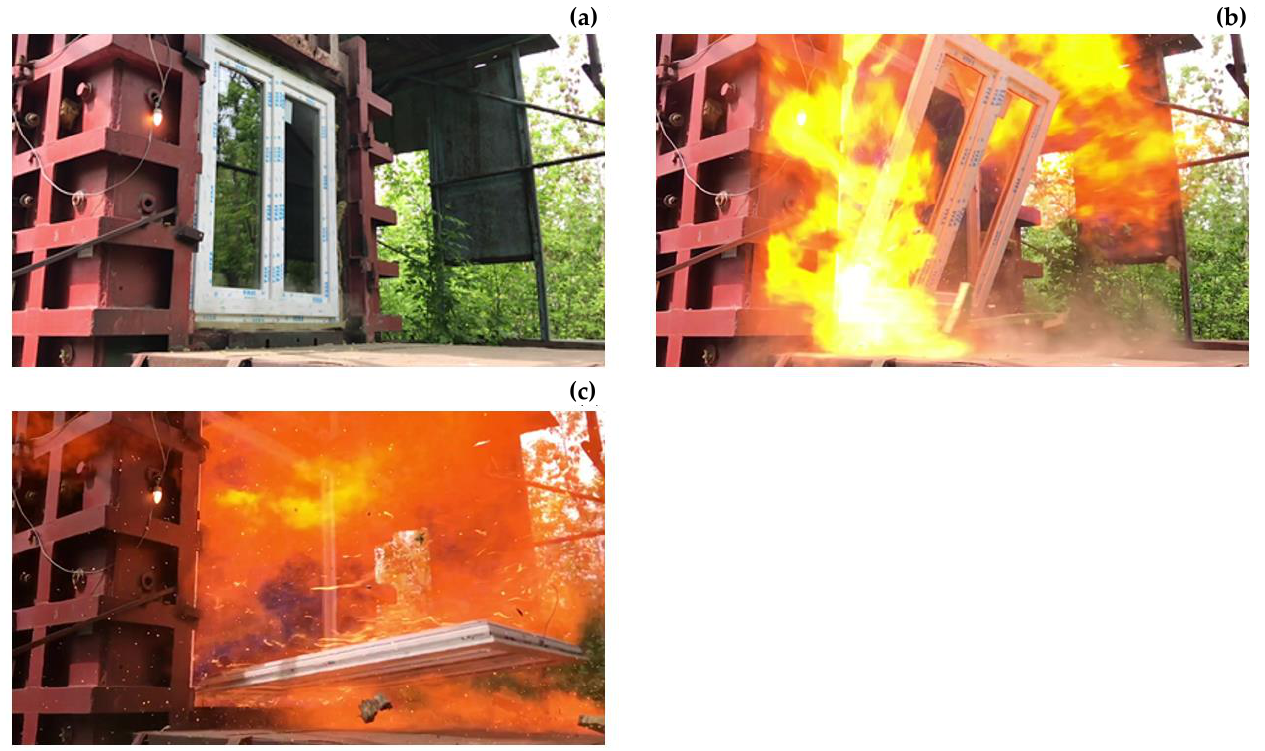
Figure 8. Instant photo of several moments of a deflagration explosion in a full-scale chamber: ( a ) EVS start-to-open moment (108.3 ms); ( b ) the relief-opening cross-section clears the EVS (191.7 ms); ( c ) the relief opening is fully clear, and the gas-air mixture burns out inside the chamber (420.8 ms).